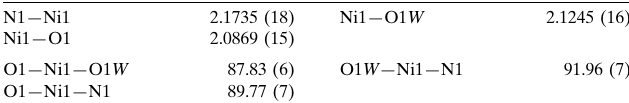
Selected bond lengths (A˚ ).